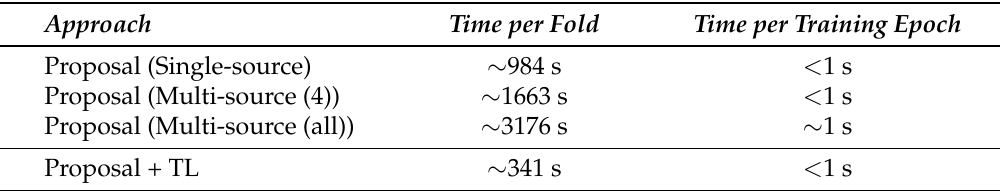
Table 3. Computational time experiments. The achieved training time (average) per fold and epoch is